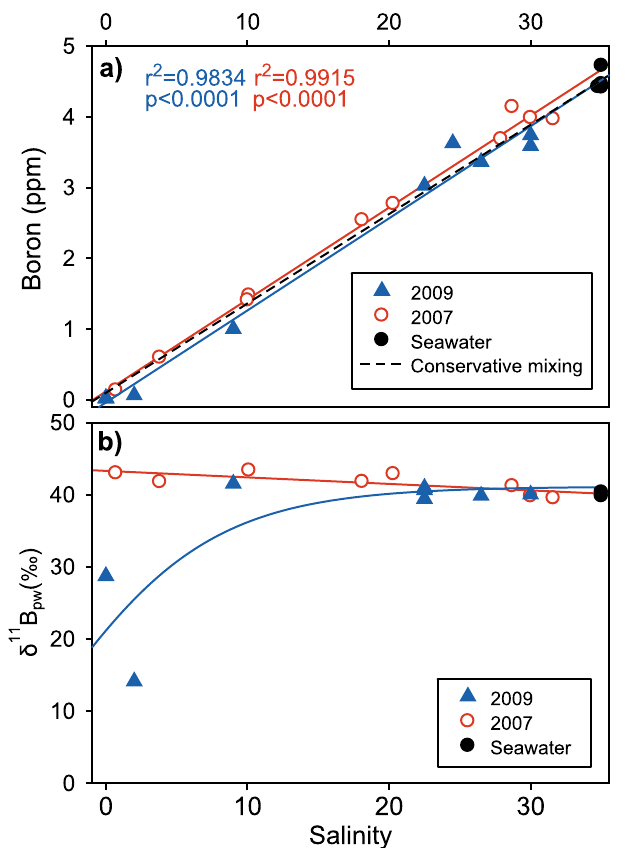
Figure 2. (a) Boron concentration plotted against salinity of wa- ters from the flood events of 2007 and 2009. A linear regression through the data is compared to the theoretical conservative mixing relationship based on a seawater end member with 4.52mg B / L at S = 35. (b) Boron isotope composition of waters along salinity transects from the 2007 and 2009 flood